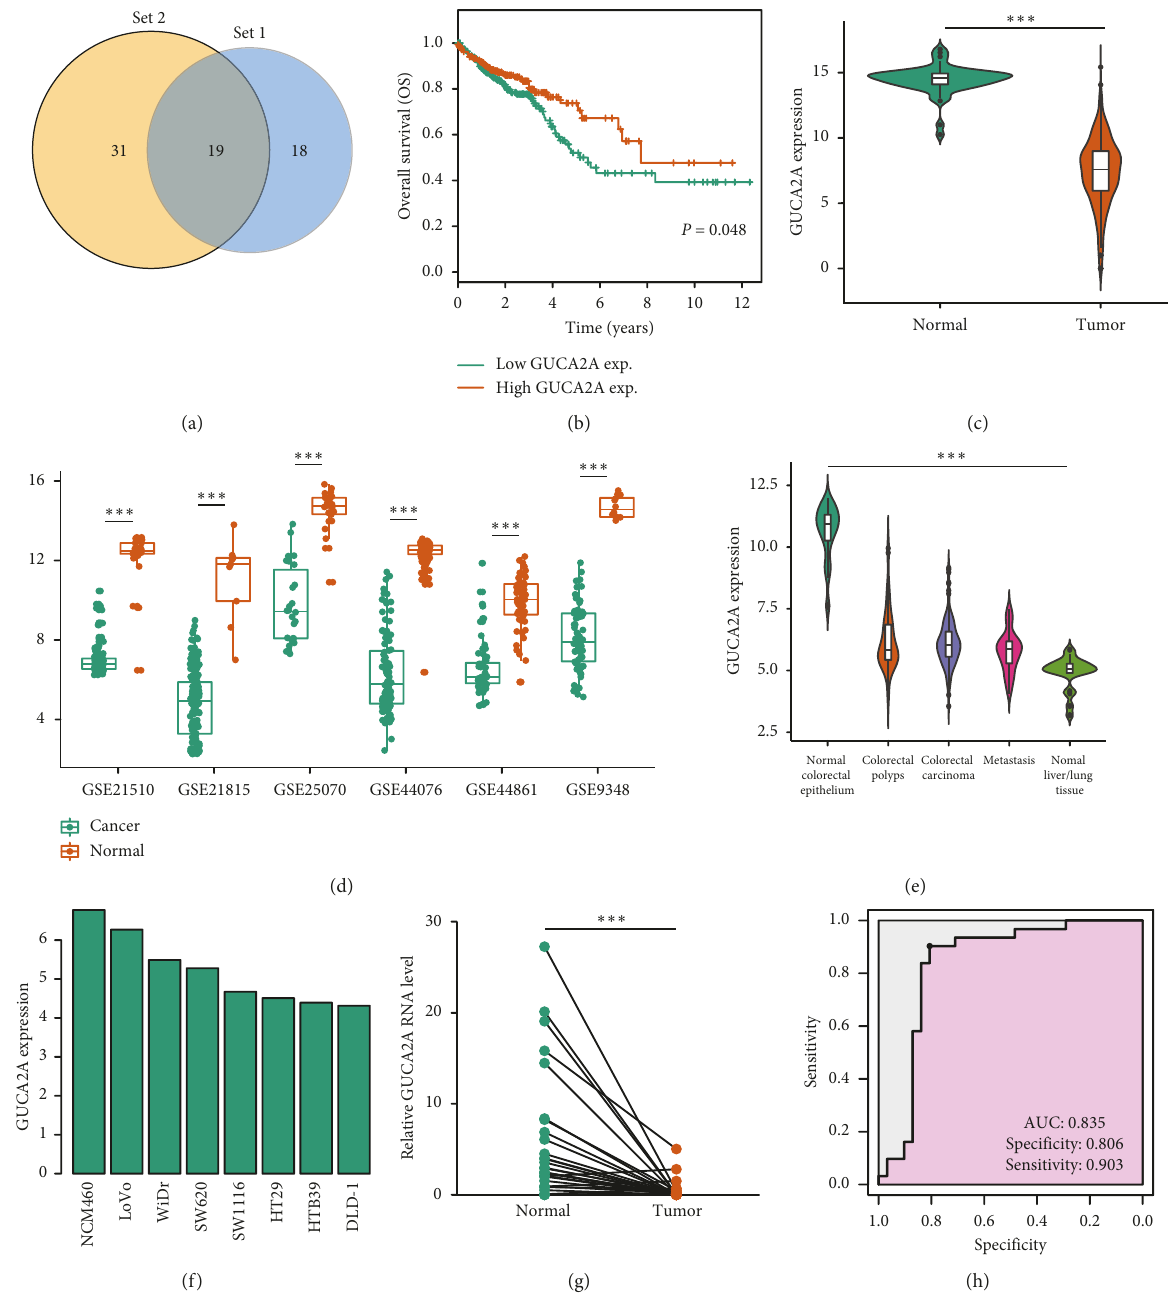
Figure 4: Aberrant expression of GUCA2A can be a candidate prognostic biomarker in CRC. (a) Venn diagram of the robust DEGs and genes in the red module revealed 19 interacting genes. Set 1: hub genes in the red module; Set 2: downregulated DEGs. (b) Five-year OS of CRC patients from the TCGA database ( P � 0 . 048). Patients with a low expression of GUCA2A have a significantly shorter OS. (c) GUCA2A expression in the TCGA database. (d) GUAC2A expression between CRC tissues and normal tissues in the six datasets. (e) GUAC2A expression in different tissue histology. (f) CRC cells in GSE68468. (g) GUCA2A expression levels in human CRC and their matched adjacent normal tissues. (h) ROC curves of tissue GUCA2A expression for differentiating CRC tissue from normal tissue. ∗∗∗ P < 0 .